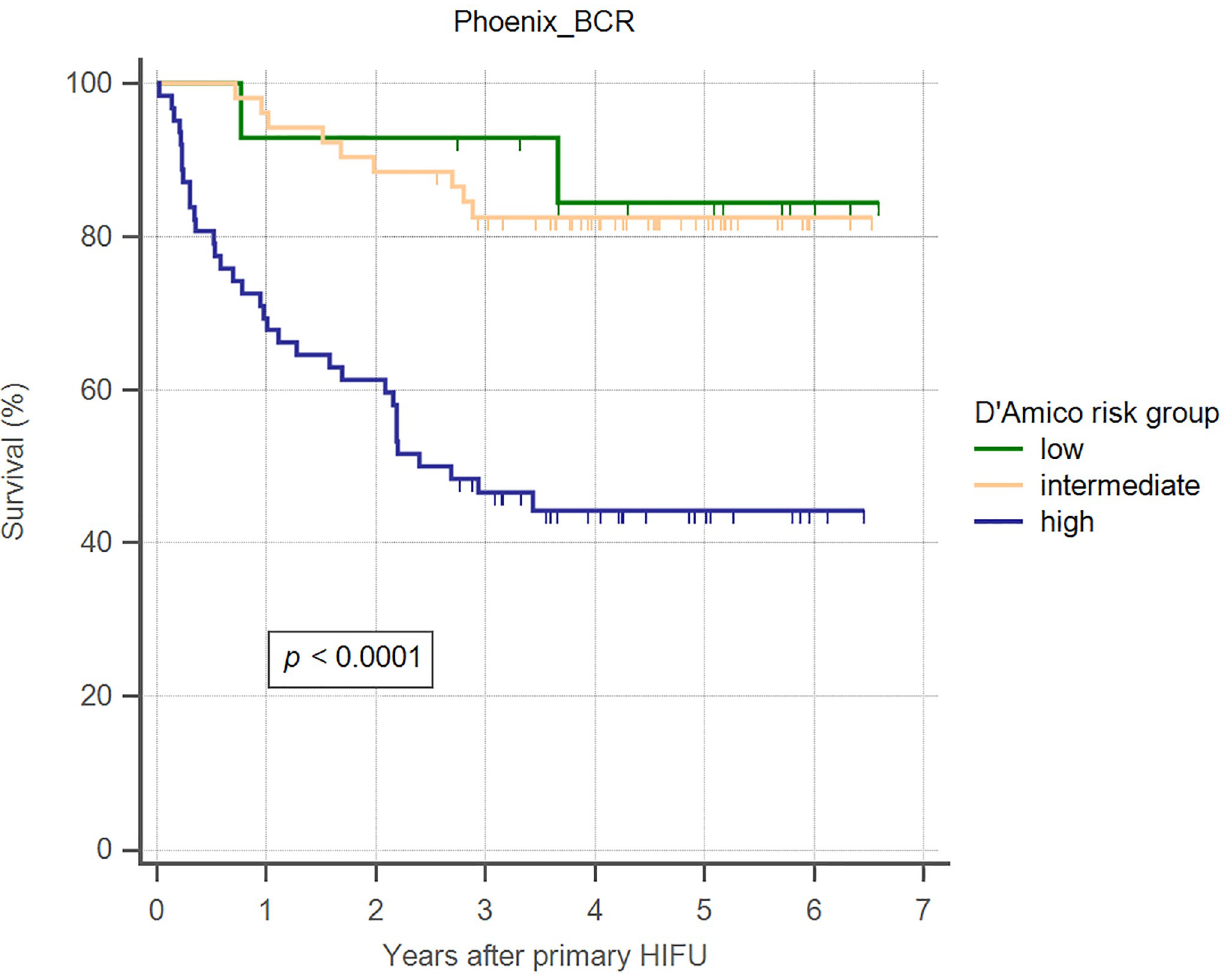
Fig 2. Kaplan–Meier curves illustrating biochemical recurrence–free survival (Phoenix criteria), by D’Amico risk groups, in men undergoing WG-HIFU for prostate cancer.